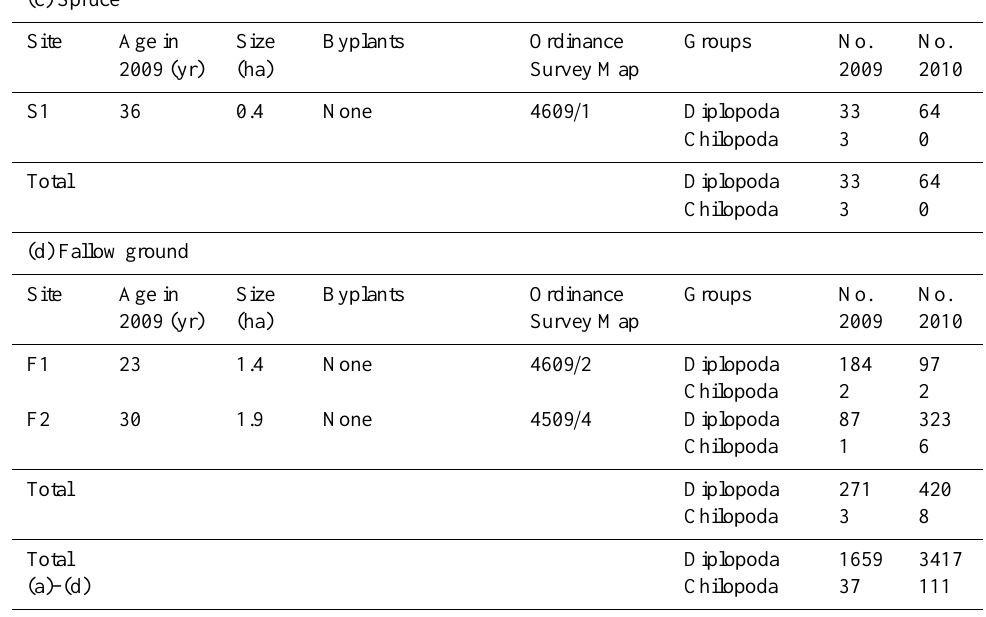
Table 1); all but the fallow-ground sites based on loam soil and had a history of forestry. They were studied over 2 com- plete vegetation periods (April–October each in 2009 and 2010). Millipedes and centipedes (Myriapoda: Diplopoda, Chilopoda) were collected by pitfall traps (Barber, 1931) and occasional manual sampling (in order to complete the species inventory), and determined to the species. In 2009 only, ani- mals were determined to their sexes in order to study changes in activity densities between males and females. For reasons of comparability, only the ground-trapping results were fur- ther analyzed and used as the data base for our Tables and